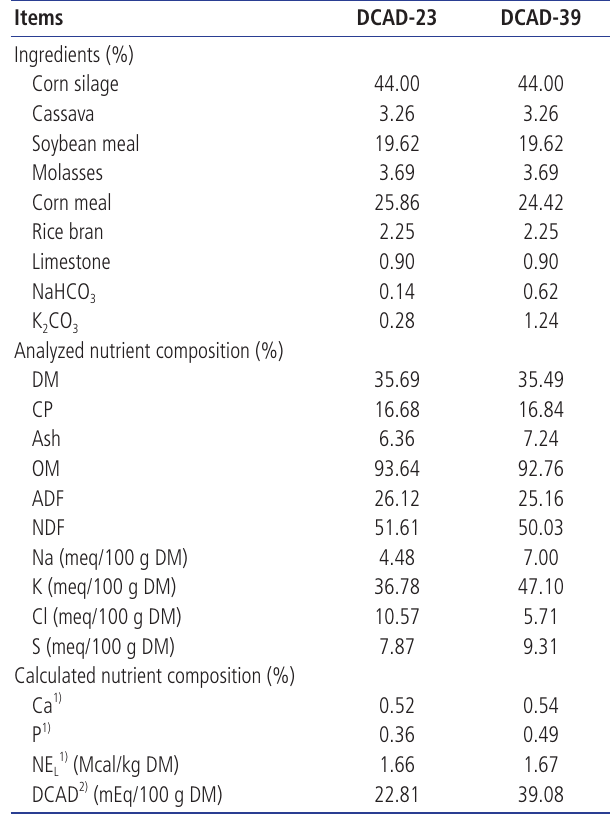
Table 1. Feed ingredients and chemical compositions of experimental diets (DM basis) differing in dietary cation-anion difference